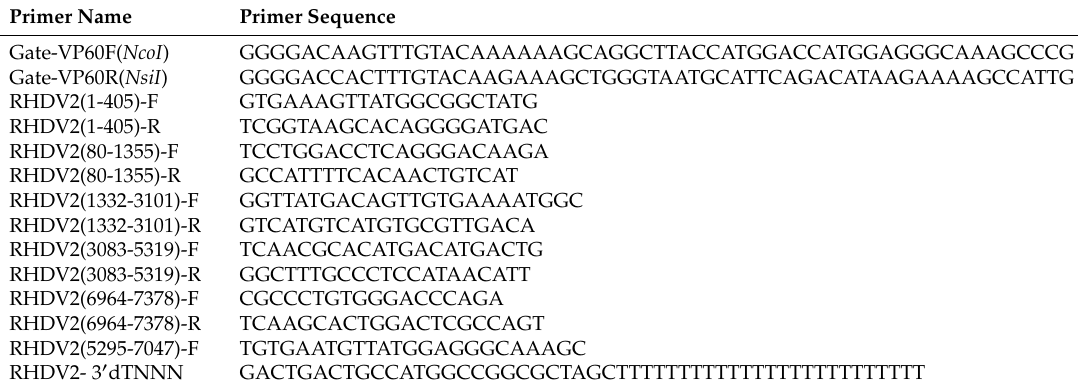
Table 1. Primers designed for amplification of the complete genome of a rabbit haemorrhagic disease virus type 2 strain from the Netherlands (RHDV2-NL2016).